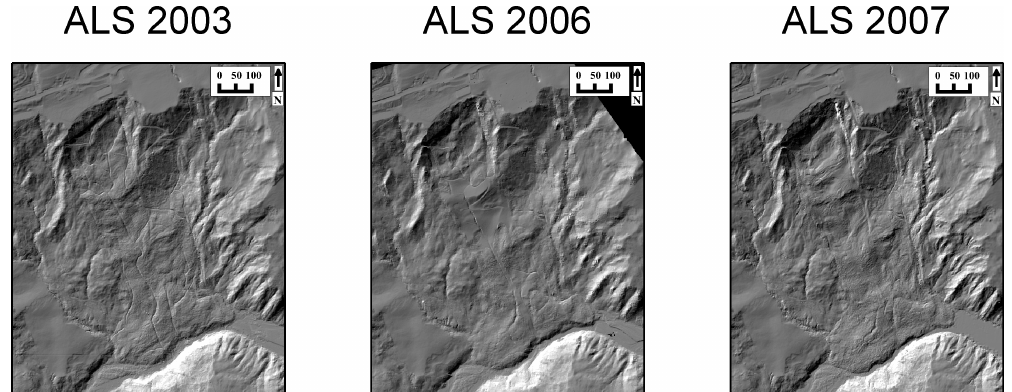
Figure 2. Shaded digital terrain models (DTMs) from airborne laser scanning (ALS) 2003, 2006 and 2007. Hillshades correspond to the northwest Sun position, and DTMs are generated using an orthographic vertical projection (plan view). The same configuration is used for shaded DTMs throughout the paper. Left bottom and right top coordinates of the DTMs are [-34202, 5260749; -33387,5261737]. The coordinate system is Austria Gauss-Kr ¨ uger M28